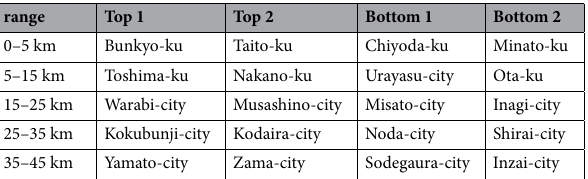
Table 1. Municipalities with the two highest/lowest population densities in each